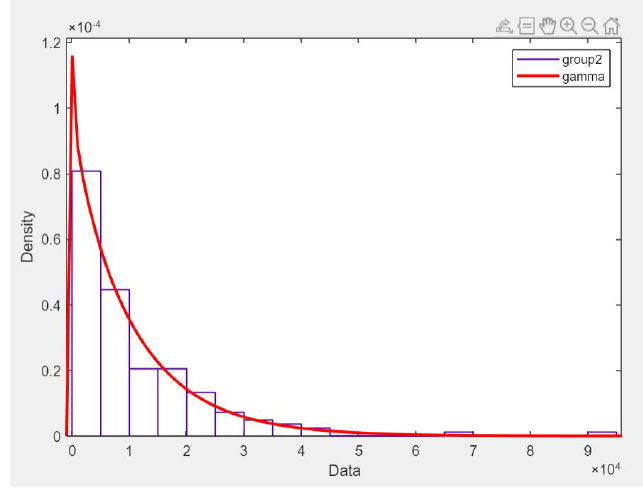
Figure 13. HISTFIT for group 2 in Category D.